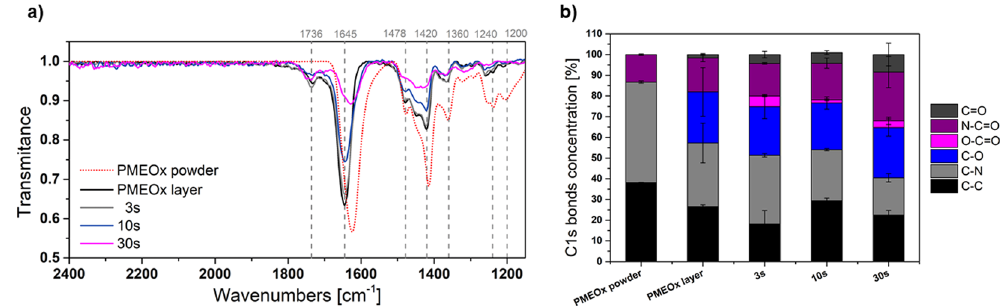
Figure 3. Optimization of plasma exposure time used for post-treatment of PMEOx coatings. ( a ) FTIR spectra of PMEOx powder (red dot line), PMEOx layer (black line) and treated PMEOx layer in different air plasma exposure times – 3 s (grey line), 10 s (blue line), 30 s (magenta line), without washing; ( b ) Relative concentrations of particular chemical bonds from high-resolution C1s spectra of air-plasma treated PMEOx layer as a function of plasma exposure time measured by